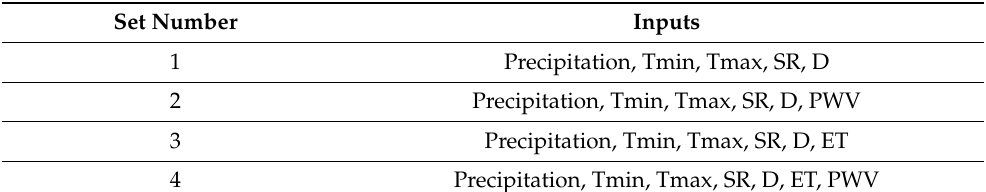
Table 6. Different input sets of the ANN. D refers to groundwater level depth.